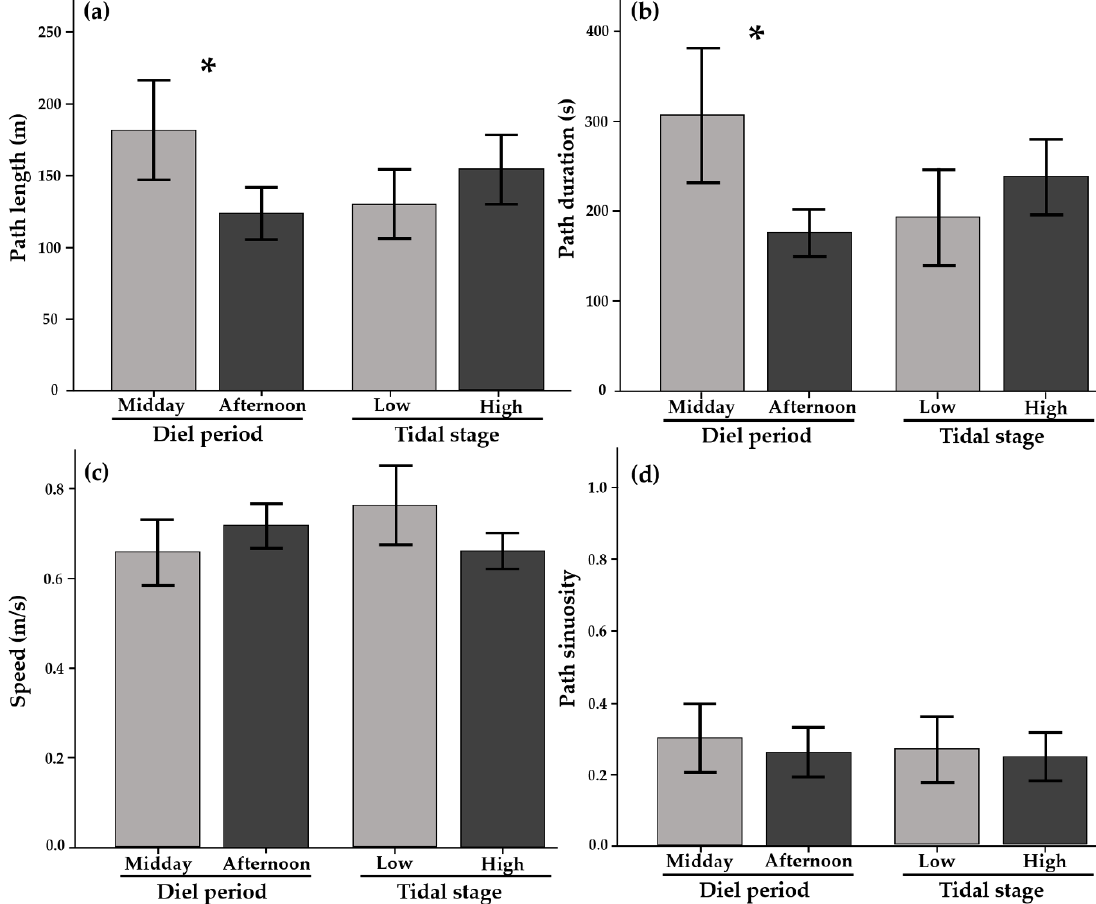
Figure 2. Comparison between the mean ( ± SE) ( a ) path length, ( b ) duration, ( c ) speed, and ( d ) sinuosity for each diel period and tidal state ( n t = 93). Significant differences ( p < 0.05) in the Mann–Whitney–Wilcoxon tests are denoted by *.